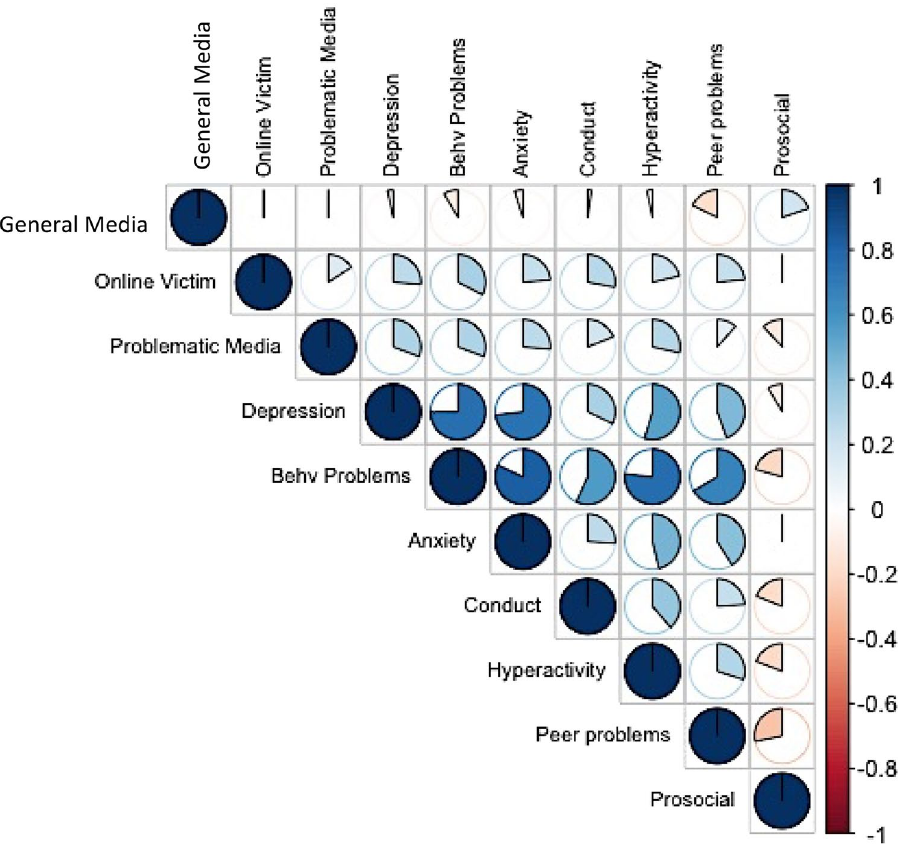
Figure 1. Phenotypic correlations between media use and mental health measures. Note : Behv Problems = the behavioural problems subdomain of the Strength and Difficulties Questionnaire 39